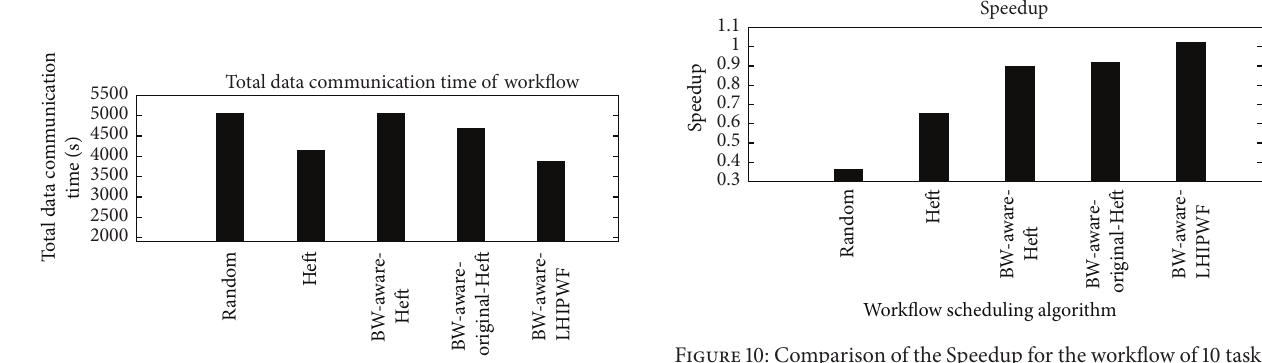
Figure 10: Comparison of the Speedup for the workflow of 10